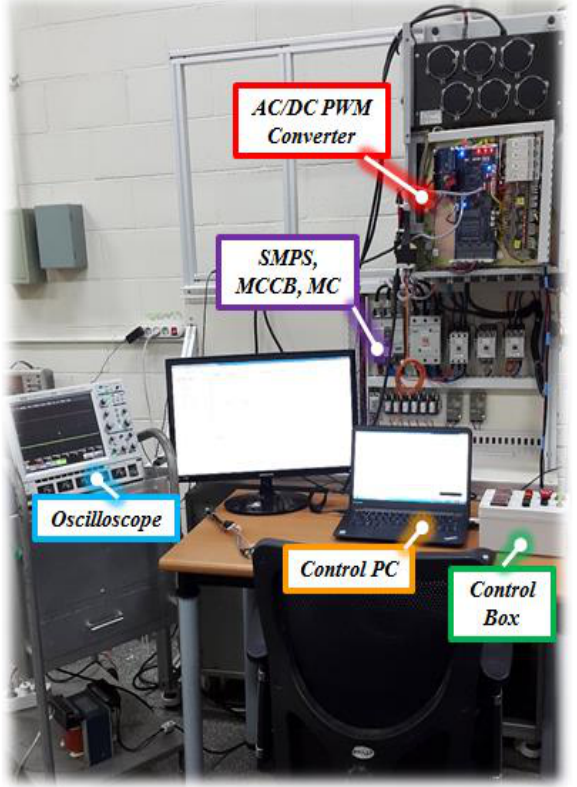
Figure 23. Experiment setup 1 of the 3-phase AC/DC PWM converter.